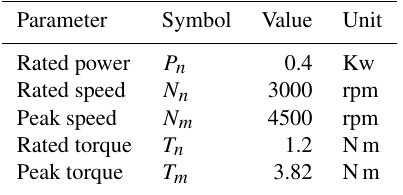
Table 1. Parameter of the Kollmorge CKM04 servo motor.